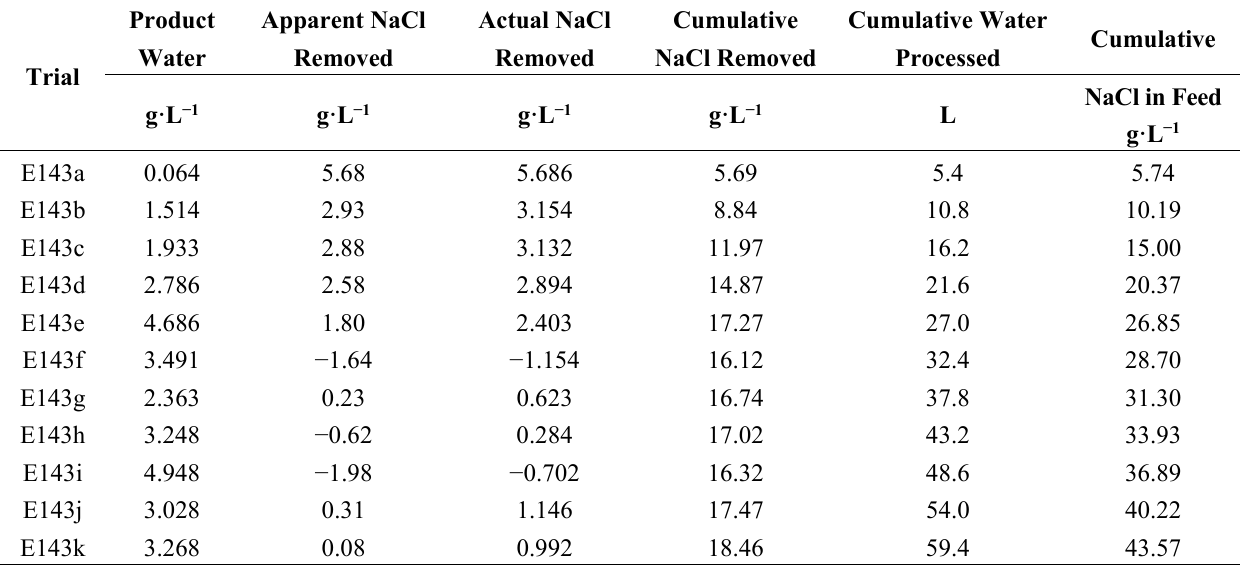
Table C8. ZVM TPA Example (Trial E143): Salinity Changes calculated from changes in EC and changes in water volume.